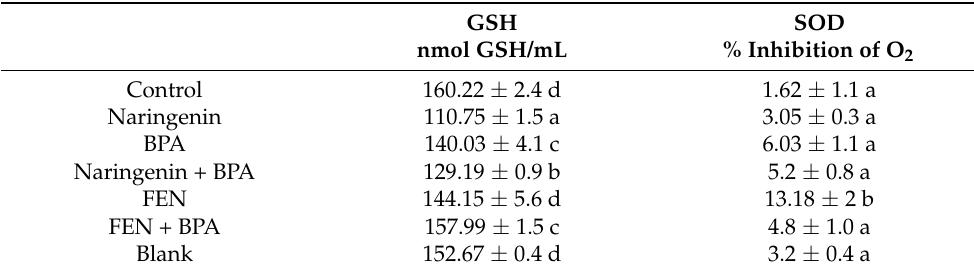
Table 2. Effect of Naringenin, BPA, FEN and co-exposition treatments on oxidative stress in HT29 cells after 24 h of treatment.